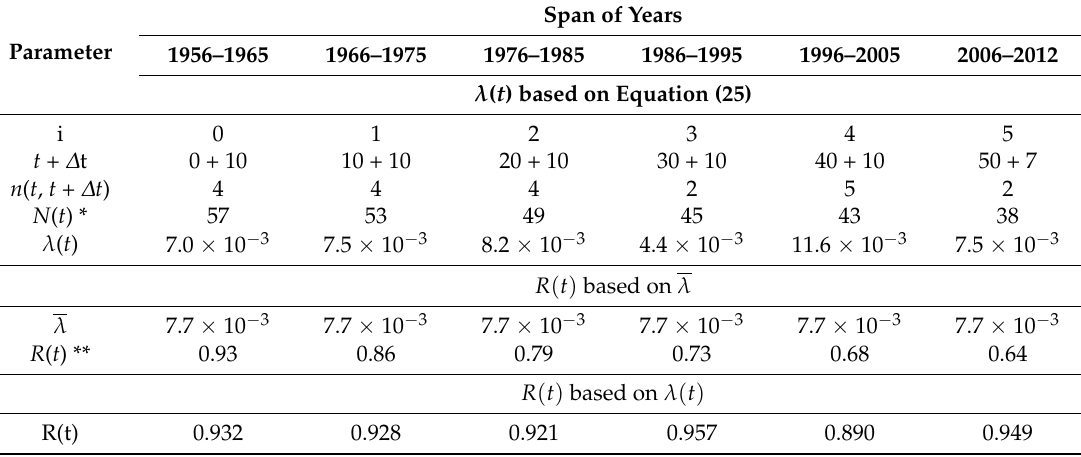
Table 2. Values of failure intensity, λ ( t ), and reliability function R ( t ) based on λ and λ ( t ) for consecutive decades of the observation period 1956–2012 for the Sola River catchment at Zywiec